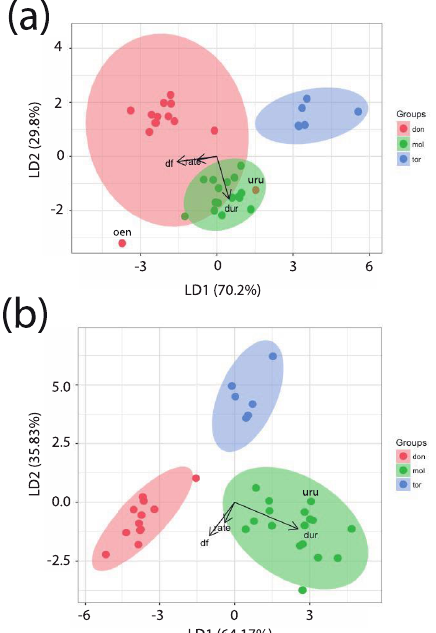
Figure 12. Ordination biplots obtained from the linear discriminant analysis (LDA) output. ( a ) Analysis performed with P. urubambensis and P. oenanthe both assigned to the donacophilus lineage. The two misclassified data points have been labeled by their acronym. ( b ) Analysis performed with P. urubambensis assigned to the moloch group (uru), and P. oenanthe being excluded. The proportion of separation achieved by each discriminant function (LD1 and LD2) is shown in brackets. Each data point represents a score resulting from the linear combination of the three predictors that best separates the three lineages. The scatter around each centroid is such that there is considerable overlap (top) or no overlap (bottom) between lineages. The shape of the 95% confidence ellipse around each centroid depicts the influence of each of the three predictors on the within-group variance. The loadings of each predictor variable are plotted as arrows (or vectors) labeled with the name of the predictor variable. Arrow length indicates the variance and the angle between arrows portrays the degree of correlation between predictors. For instance, the small angle between df and rate reflects a high correlation between these two variables, with df and dur exhibiting larger variances compared with rate. Both df and rate are almost at right angle with dur, which signifies the absence of correlation between these pairs of variables. The two dots just outside the 95% confidence ellipses in panel b are from P. modestus (red dot) and P. discolor (green dot).